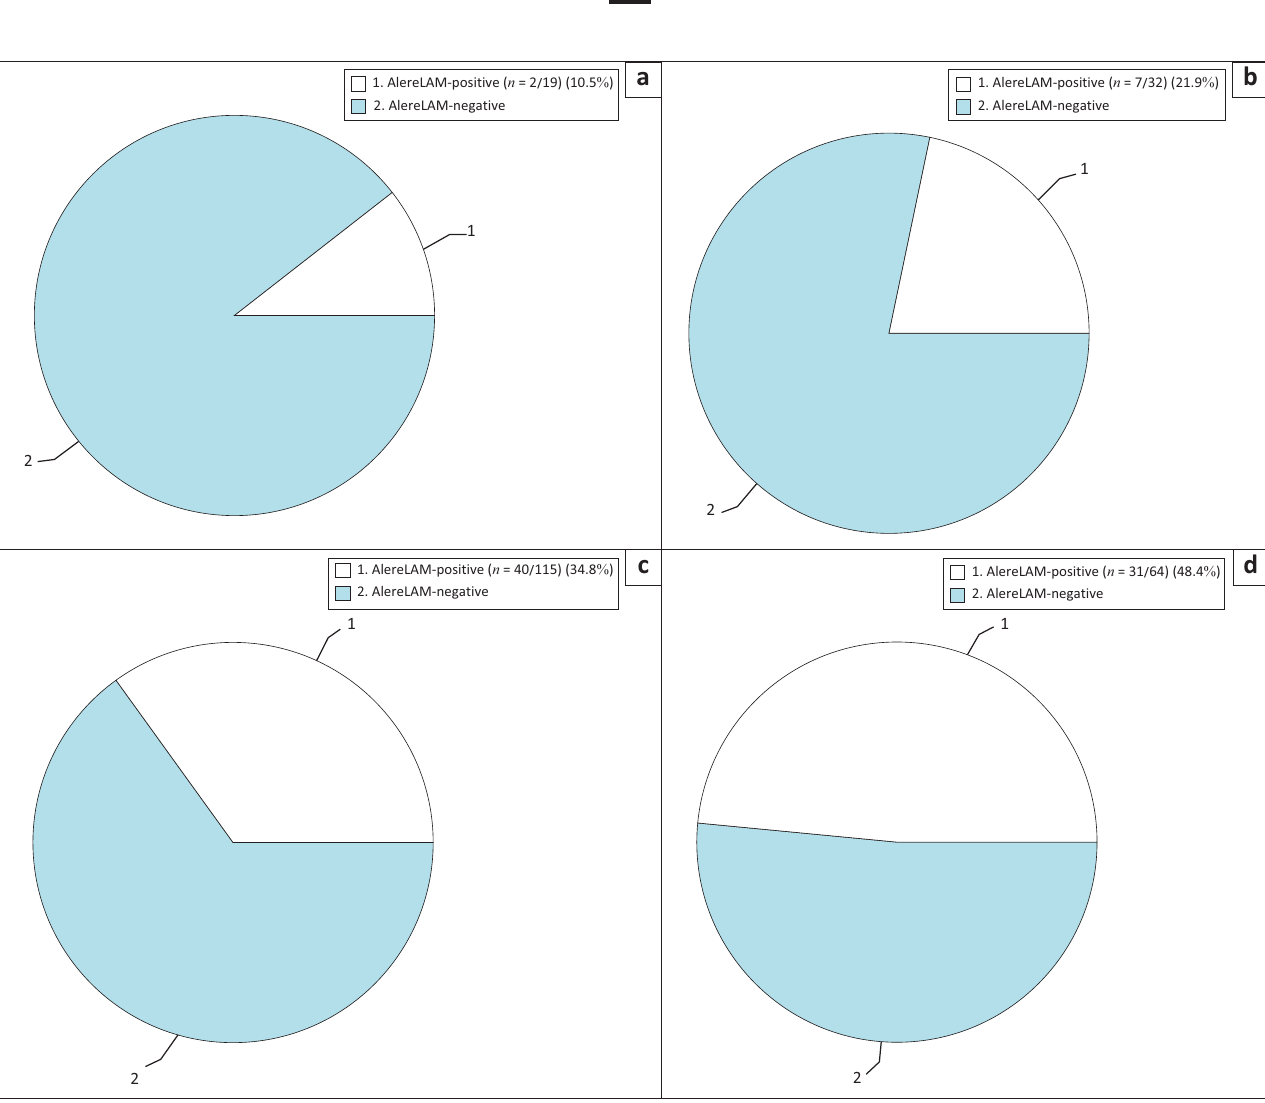
FIGURE 3: AlereLAM-positive prevalence in (a) patients with CD4 ≤ 100 but not meeting ‘seriously ill’ criteria, (b) those with ‘seriously ill’ criteria but CD4 > 100, (c) those with either CD4 ≤ 100 or ‘seriously ill’ criteria, and (d) those meeting both CD4 ≤ 100 and ‘seriously ill’